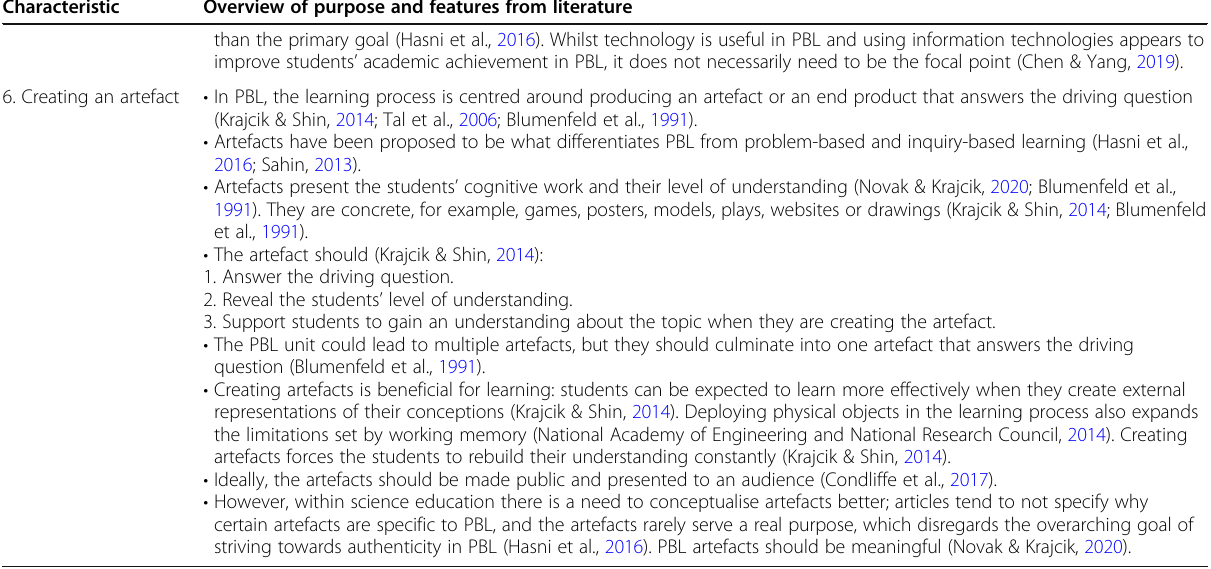
Table 1 Framework of the key characteristics of PBL. The six characteristics are as proposed by Krajcik & Shin (2014) (Continued) Characteristic Overview of purpose and features from